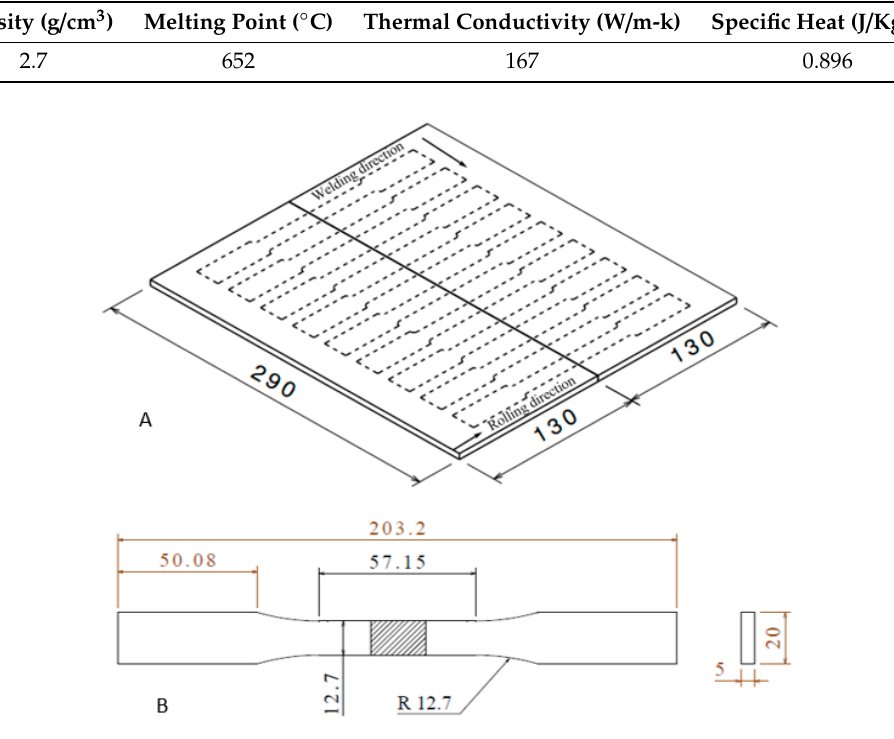
Figure 2. Pattern of welding with respect to rolling direction and removal of tensile specimen: ( A ) Dimension of the flat tensile specimen, ( B ) welded specimen according to (ASTM E8-04).